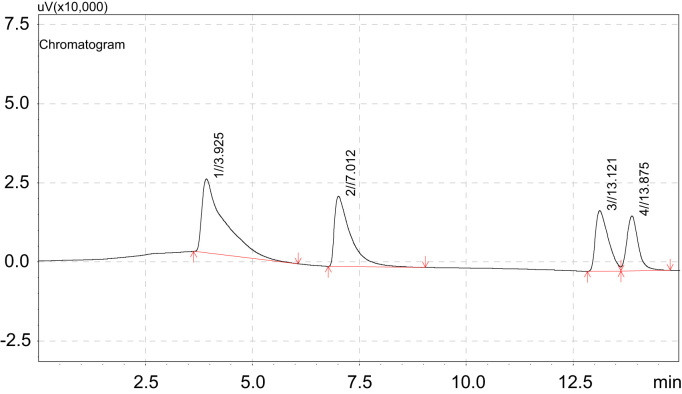
Sample standard.